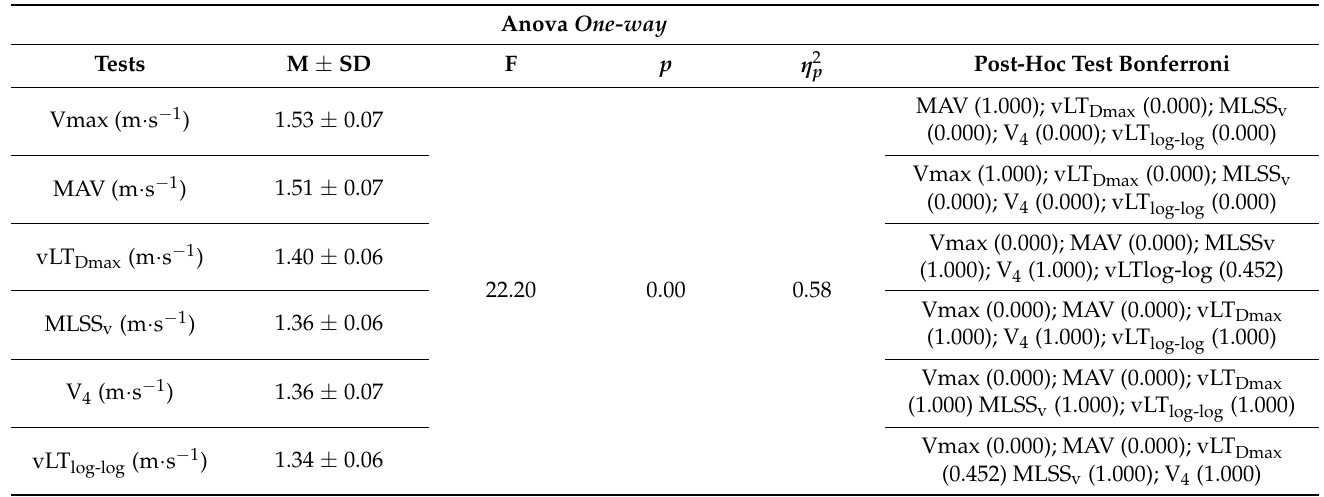
Table 1. Comparative analysis between different swimming velocities.